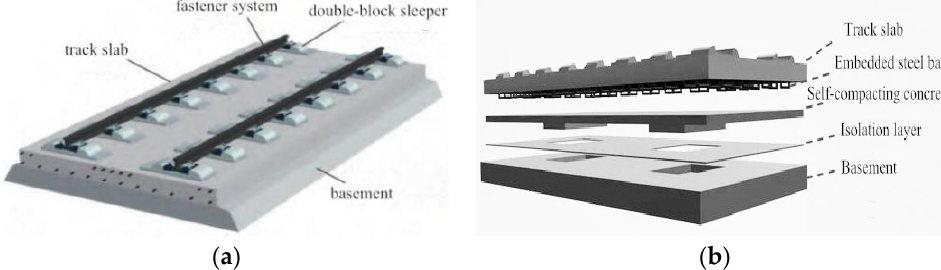
Figure 1. Unit-plate ballastless tracks. ( a ) Double-block type ballastless track; ( b ) CRTS III type ballastless track.